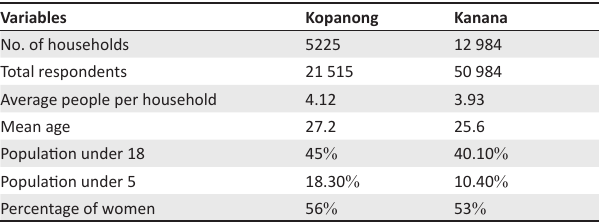
TABLE 1: Summary of participant characteristics for Kopanong and Kanana